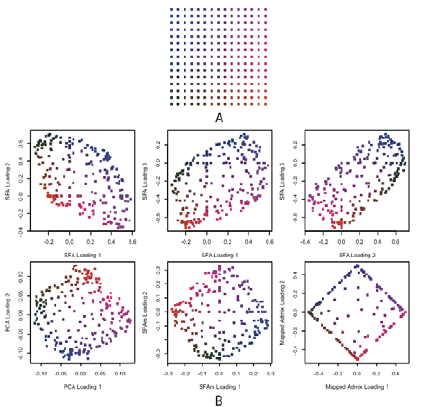
Figure 6. Results of SFA, PCA, SFAm, and ADMIXTURE applied to simulated genotype data from a single 2-D habitat. In Panel A, each dot represents a population colored according to location. In Panel B, each plot is of the loadings across individuals against each other, where the colors correspond to their locations in Panel A. The first row shows the three SFA loadings against each other from a three factor model. The second row shows the second two PCA loadings, the SFAm loadings, and the mapped ADMIXTURE loadings (see text for details). All of the methods recapitulate, to a greater or lesser extent, the geographical structure of the habitats (up to rotation).